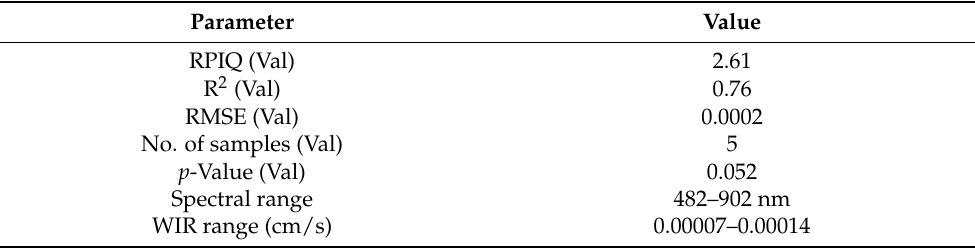
Table 6. Statistical performance of the spectral-based model that was selected to run on the Cubert reflectance